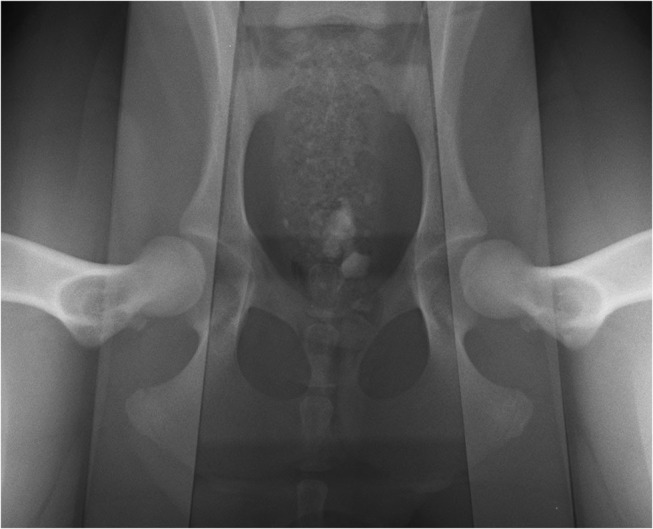
Hip distraction view using the Dis-UTAD distractor. The pelvis and the distractor are centered and symmetrical, and the more pronounced lateral band opacity of the distractor overlaps the femoral heads.